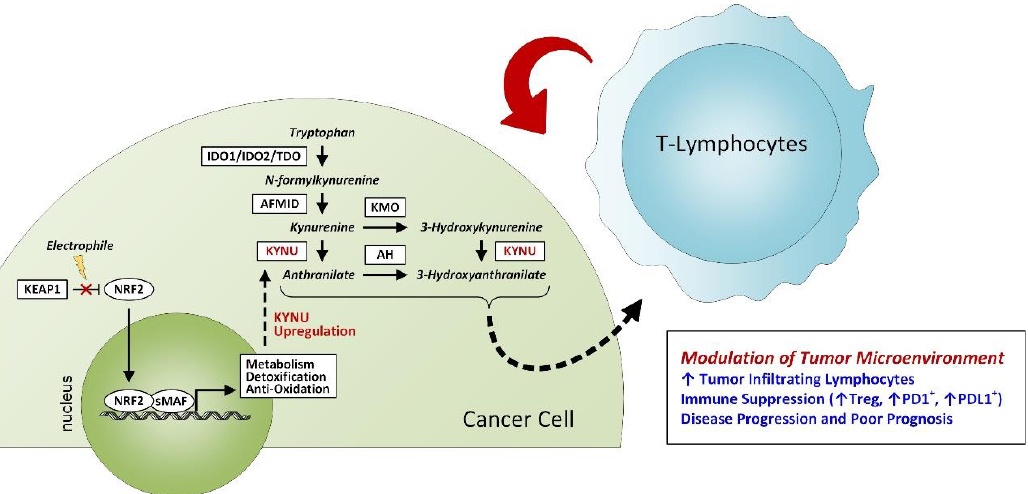
Figure 5. Proposed Schematic . NRF2 activation promotes KYNU upregulation in lung adenocarci- noma, resulting in an immunosuppressive tumor microenvironment characterized by elevated tu- mor T-cell infiltration, including T regulatory TILs, and concordant increases in protein expression of immune checkpoint blockade-related PD1 and PD-L1 and poor prognosis.